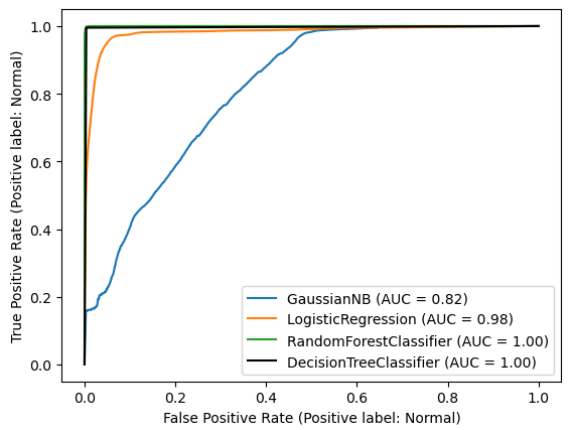
Figure 5. ROC curve for AI